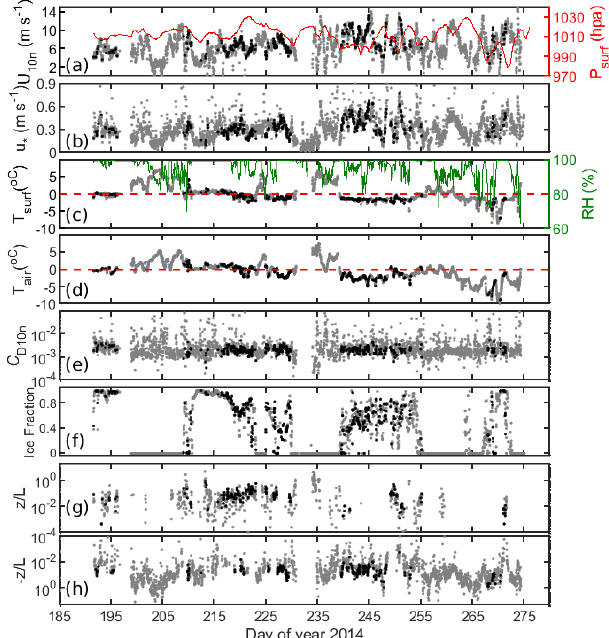
Figure 2. Time series of (a) 10m neutral wind speed, U 10n and surface pressure, P surf , (secondary axis), (b) friction velocity, u ∗ (c) surface temperature, T surf and relative humidity, RH, (sec- ondary axis), (d) air temperature, T air , (e) 10m equivalent neu- tral drag coefficient, C D10n , (f) ice fraction from AMSR2 satellite, (g) Monin–Obukhov stability parameter, z/L , for z/L> 0 (stable) and (h) z/L< 0 (unstable), for ACSE data. The grey dots are 30min flux periods from the whole cruise, whereas the black dots corre- spond to the flux data points that pass quality control. In panels (c) and (d) , the dashed red lines show T air = T surf = 0 ◦